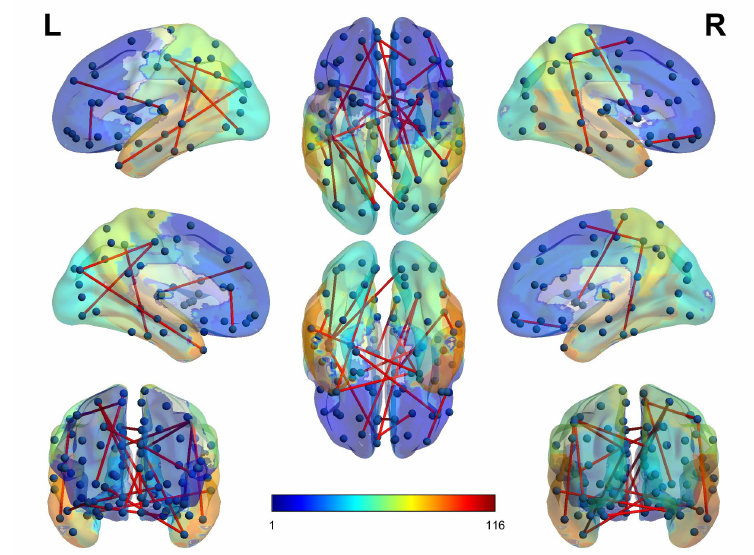
Figure 4. BrainNet visualizations of hemispherical